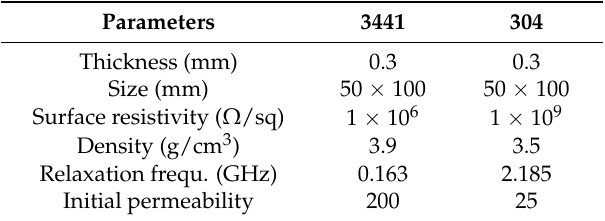
Table 1. Comparison of magnetic properties for 3441 and 304 magnetic